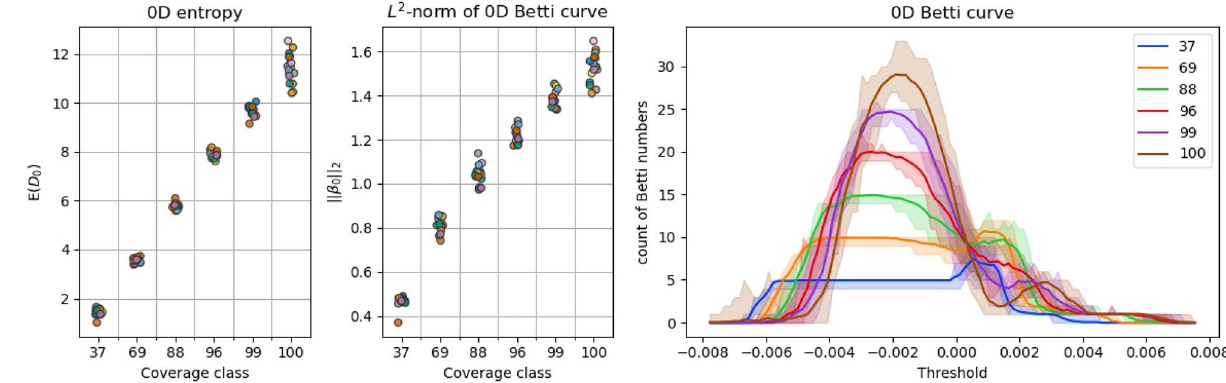
Figure 4. The persistence-based surface roughness parameters over coverage, colouring by impact sequence. Points marginally shifted in x-direction for better visibility. In addition, 0D BC over threshold value (lines = mean, shading = minimal and maximal function